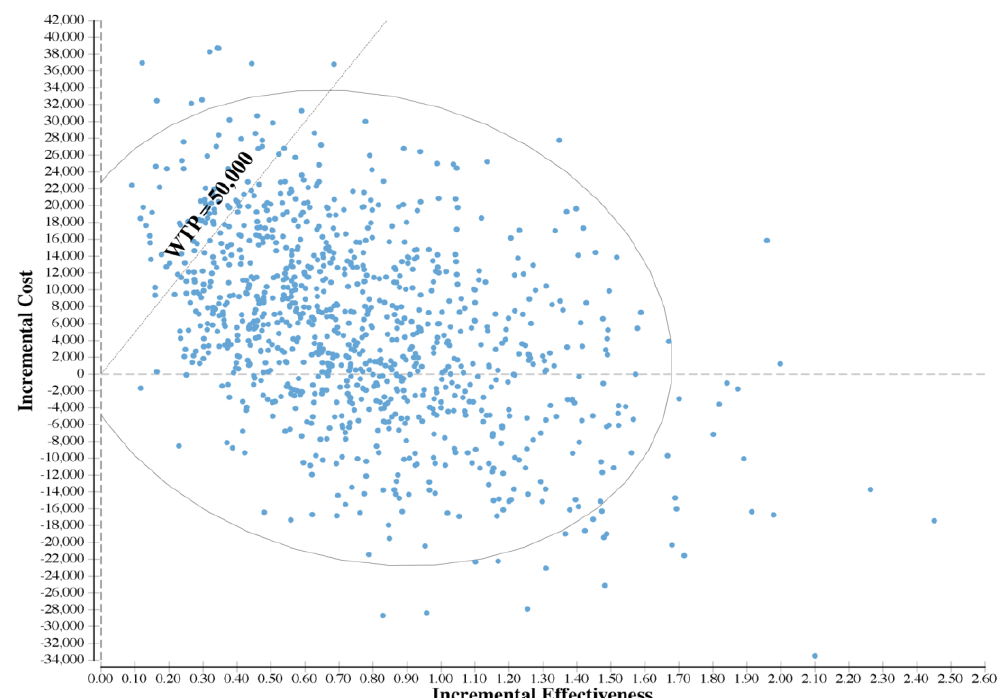
Figure 3. Incremental cost-effectiveness scatter-plot, changing the regulatory DNL level from 65 dB to 55 dB versus the status quo.